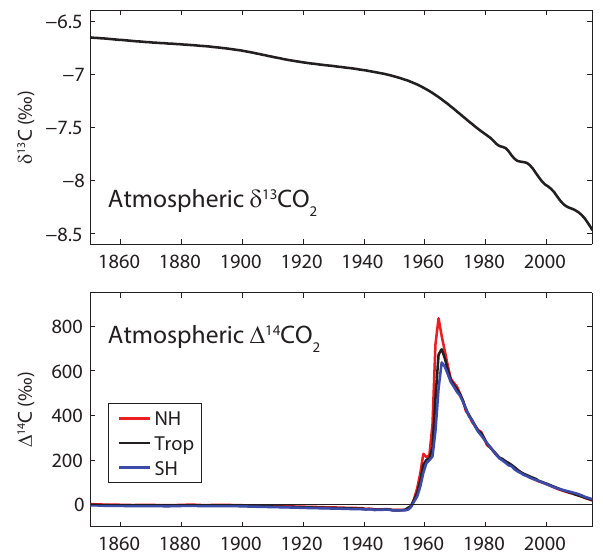
Figure 4. Carbon isotopes in atmospheric CO 2 for the historical period 1850–2014. Data for δ 13 C is from Law Dome, South Pole (Rubino et al., 2013), and Mauna Loa (Keeling et al., 2001) and includes smoothing of the observations. Data for (cid:49) 14 C are com- piled from Levin et al. (2010) and other sources (I. Levin, personal communication, 2016), following a similar data set used by Orr et al.